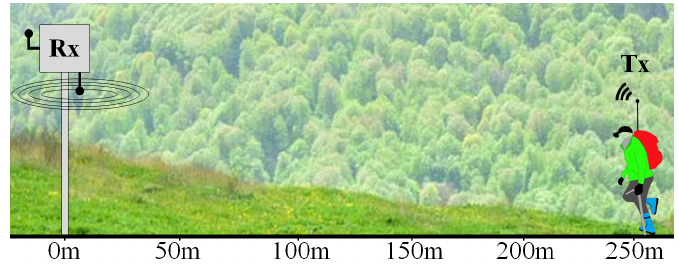
Figure 7. Short-term static scenario.